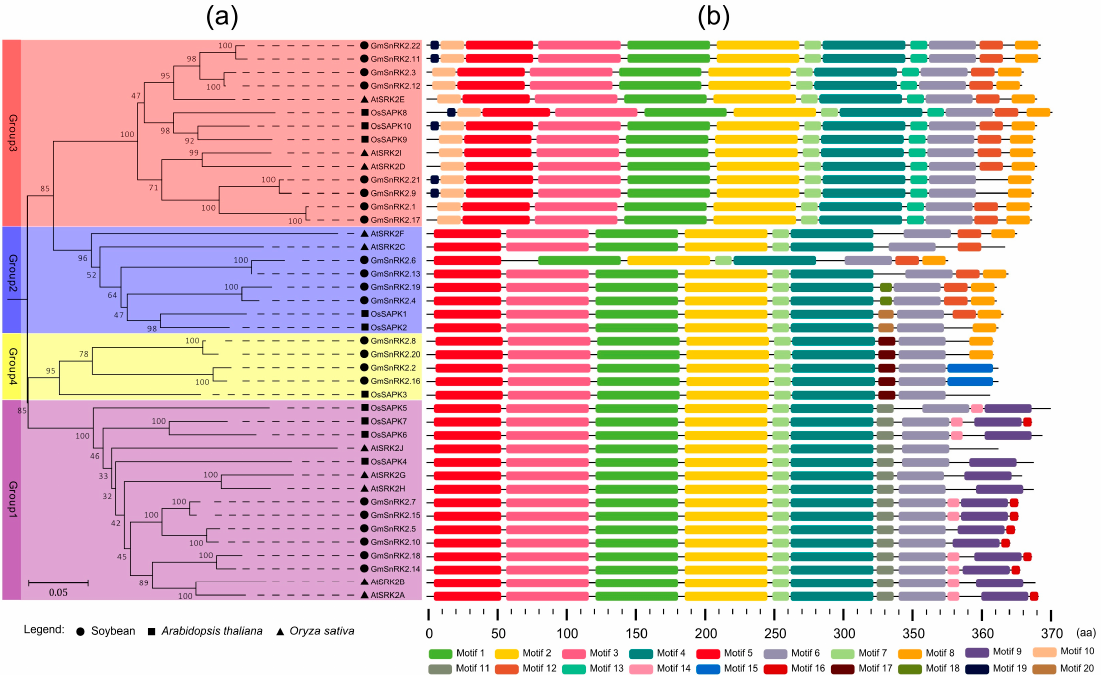
Figure 2. Phylogenetic tree and protein motif analysis of GmSnRK2s. ( a ) Phylogenetic tree of SnRK2s of Arabidopsis thaliana , Oryza sativa and soybean was constructed by the Neighbor-Joining (NJ) method using MEGA5 software (version 5.1 β , Hachioji, Tokyo, Japan). Group 1, Group 2, Group 3 and Group 4 are marked as purple, blue, red and yellow, respectively. Soybean, Arabidopsis thaliana and Oryza sativa SnRK2s are represented by black circle, square and triangle, respectively; ( b ) protein motifs of GmSnRK2s, AtSnRK2s and OsSnRK2s profiled by MEME (version 4.12.0, Seattle, WA, USA). The 20 conserved motifs are represented by colored boxes at the bottom. The scale of protein length is given below the schematic diagram.